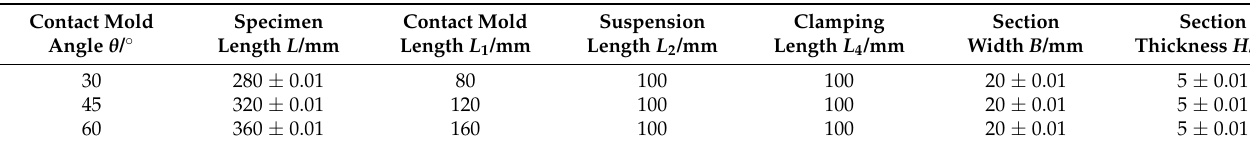
Table 4. Specimen sizes at different contact mold angles.